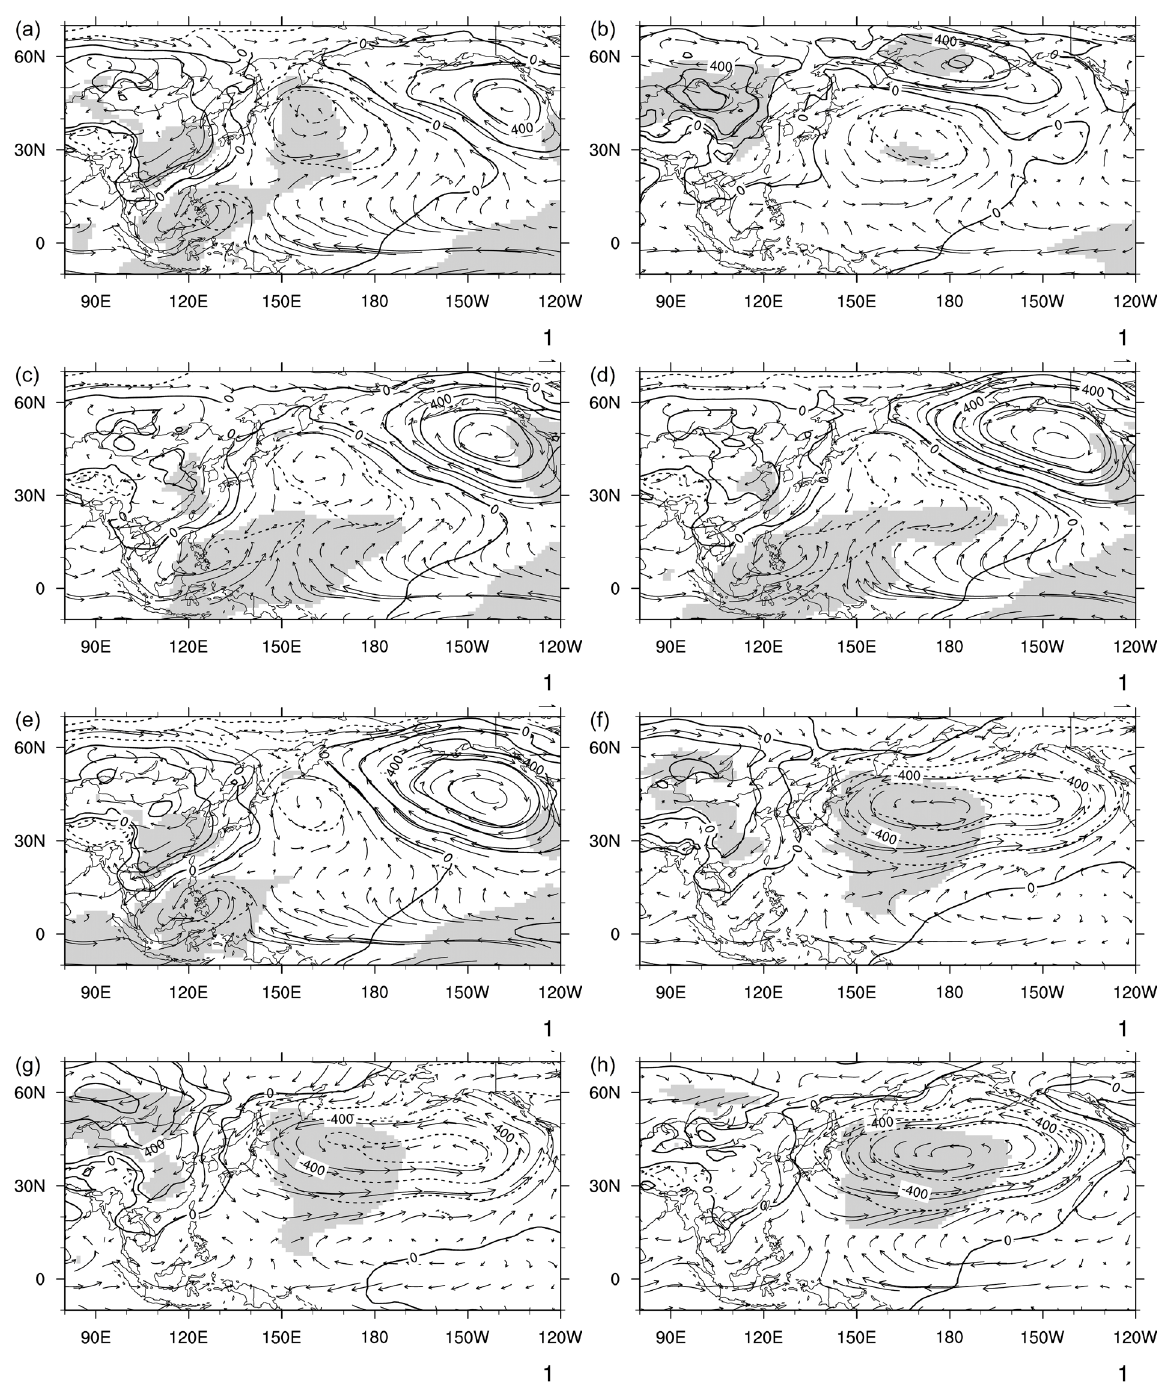
Figure 4. Spatial patterns of composite differences between positive and negative phases of the ( a ) I , ( b ) I , ( c ) I , ( d ) I , ( e ) I , ( f ) I , ( g ) I and ( h ) I indices. The Chen Liu-M Liu-L Ji Lu Xu Wu Jhun vector and contour line are the differences of wind (meters per second) and sea level pressure (hectopascals), respectively, and the shading contour is the 0.05 significance